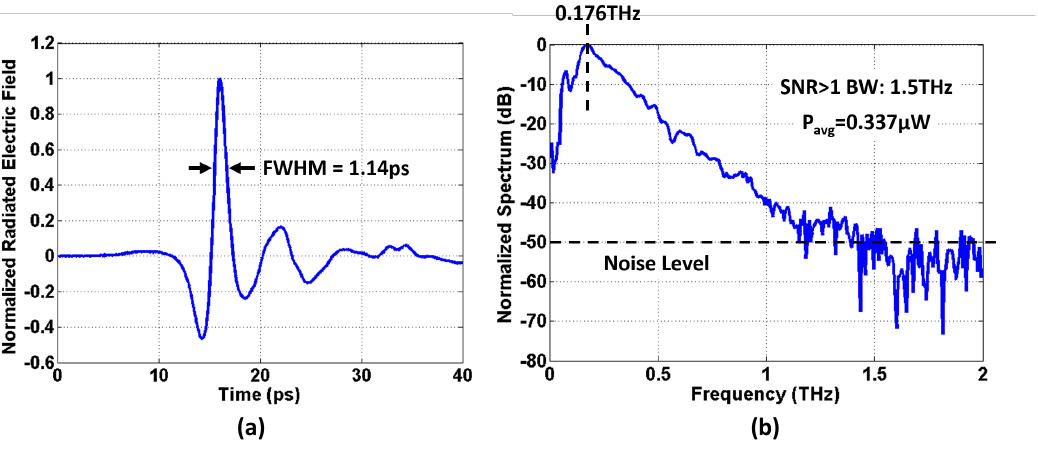
Figure 7. ( a ) Measured time-domain waveform of the radiated THz impulse. ( b ) Measured frequency-domain spectrum of the radiated THz